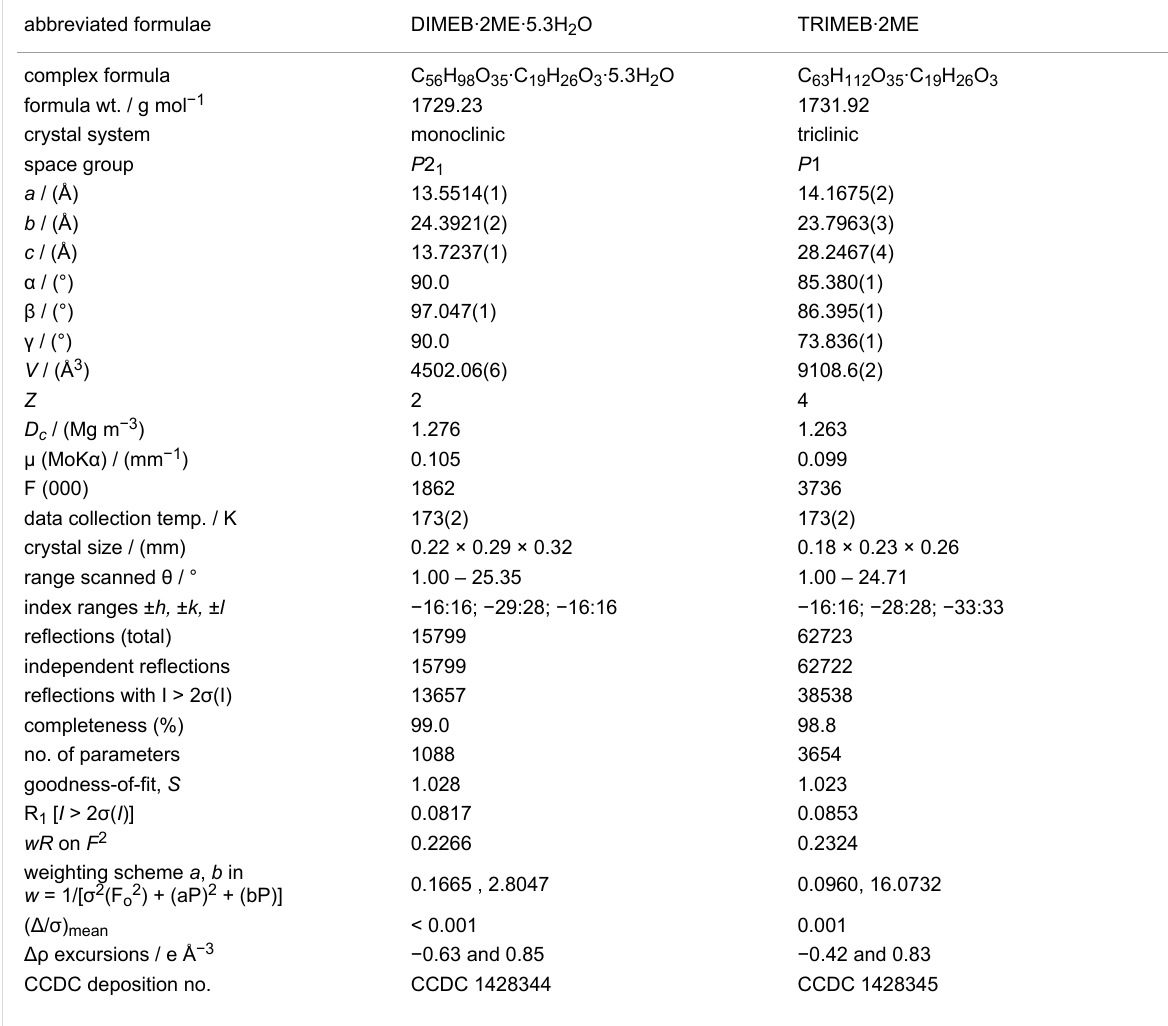
Table 1: Crystal data, data collection parameters and refinement